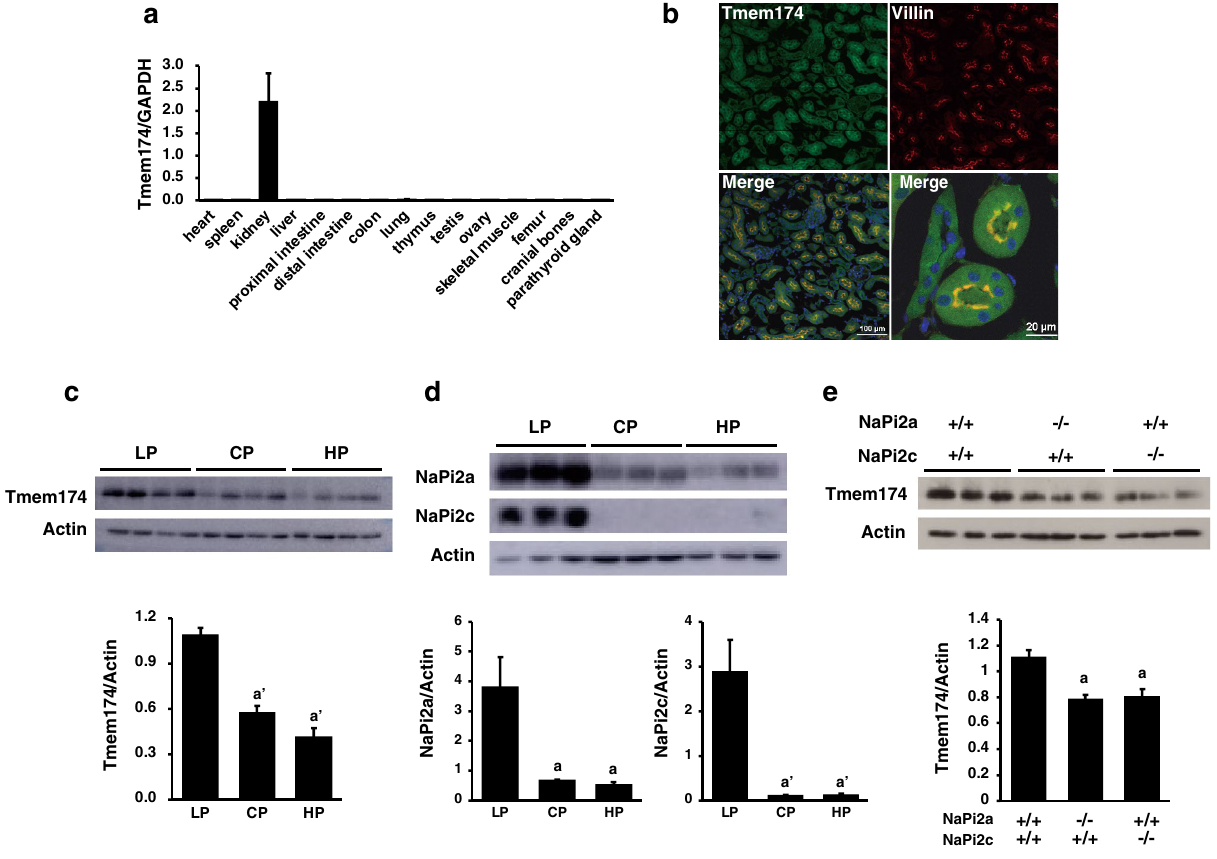
Figure 2. Tissue localization of Tmem174 expression and possible involvement in Pi homeostasis. ( a ) Tmem174 mRNA level in several tissues of wild-type (WT) mice by real-time PCR. Male mice at 8 weeks of age (n = 5–9) were used. Glyceraldehyde-3-phosphate dehydrogenase (GAPDH) was used as an internal control. Values are mean ± SE. ( b ) Immunofluorescence staining Tmem174 (green) in renal section of 8-week-old WT mice. DAPI (blue), Villin (red). Sections were prepared from mouse kidney embedded in OCT compound and frozen. ( c , d ) Western blotting analyses of the renal brush border membrane vesicles (BBMVs) isolated from the WT mice (n = 3–5) fed a low Pi (LP: 0.02%), control Pi (CP: 0.6%), and high Pi (HP: 1.2%) diet. Each lane was loaded with 20 μg of BBMVs. Actin was used as an internal control. Values are mean ± SE. a p <